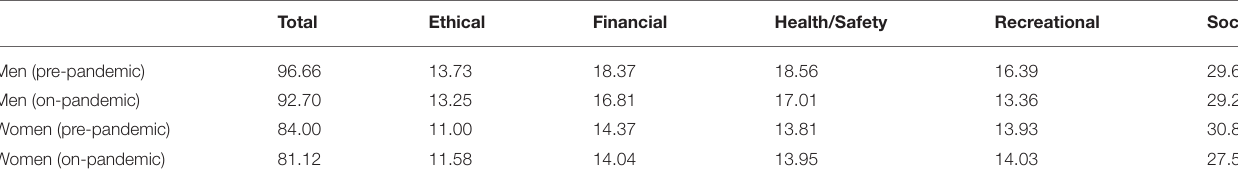
TABLE 4 | DOSPERT scores by gender.